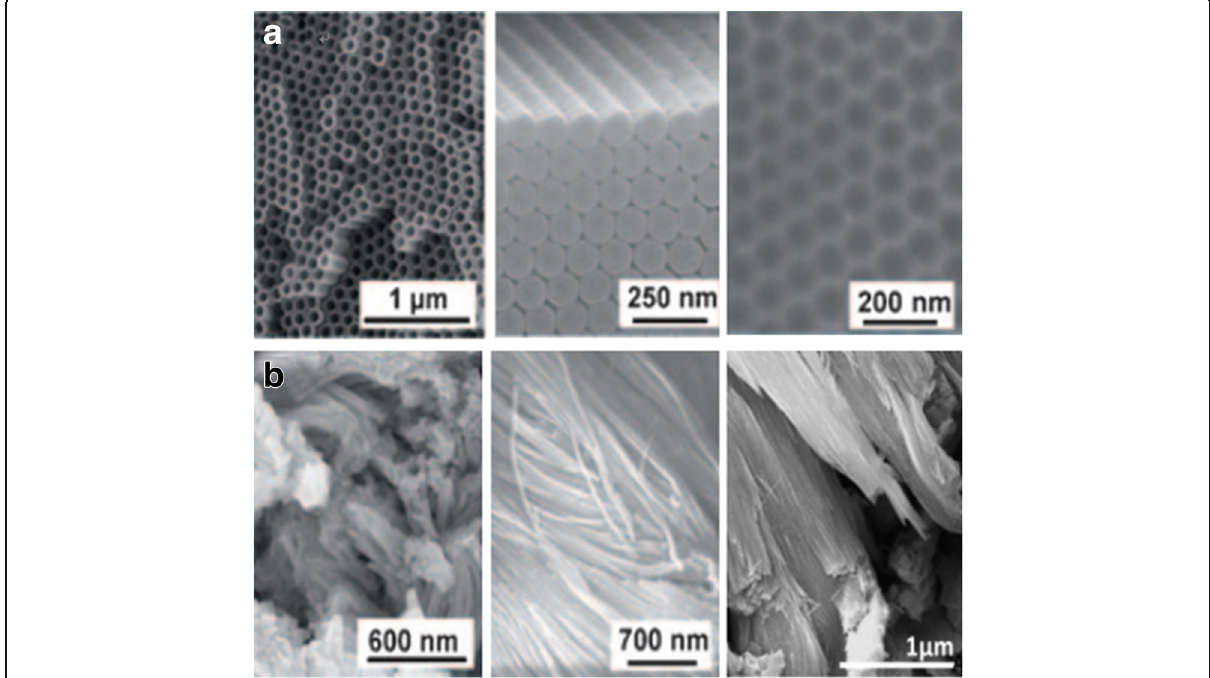
Fig. 3 SEM images of anodized TiO 2 nanotube layers by different anodization processes of Ti. a The highly ordered TiO 2 nanotubes (in top and side view) are obtained in organic electrolyte systems, with self-ordered surface dimples (right) which in fact are metallic surfaces when the tube layers are removed. Reproduced from ref. [1]. b The disordered TiO 2 nanotubes are grown in patches on the surface area and fused together to bundles in chloride containing electrolyte by an ultrafast anodization technique known as rapid-breakdown anodization (RBA). Reproduced from ref. [1] and